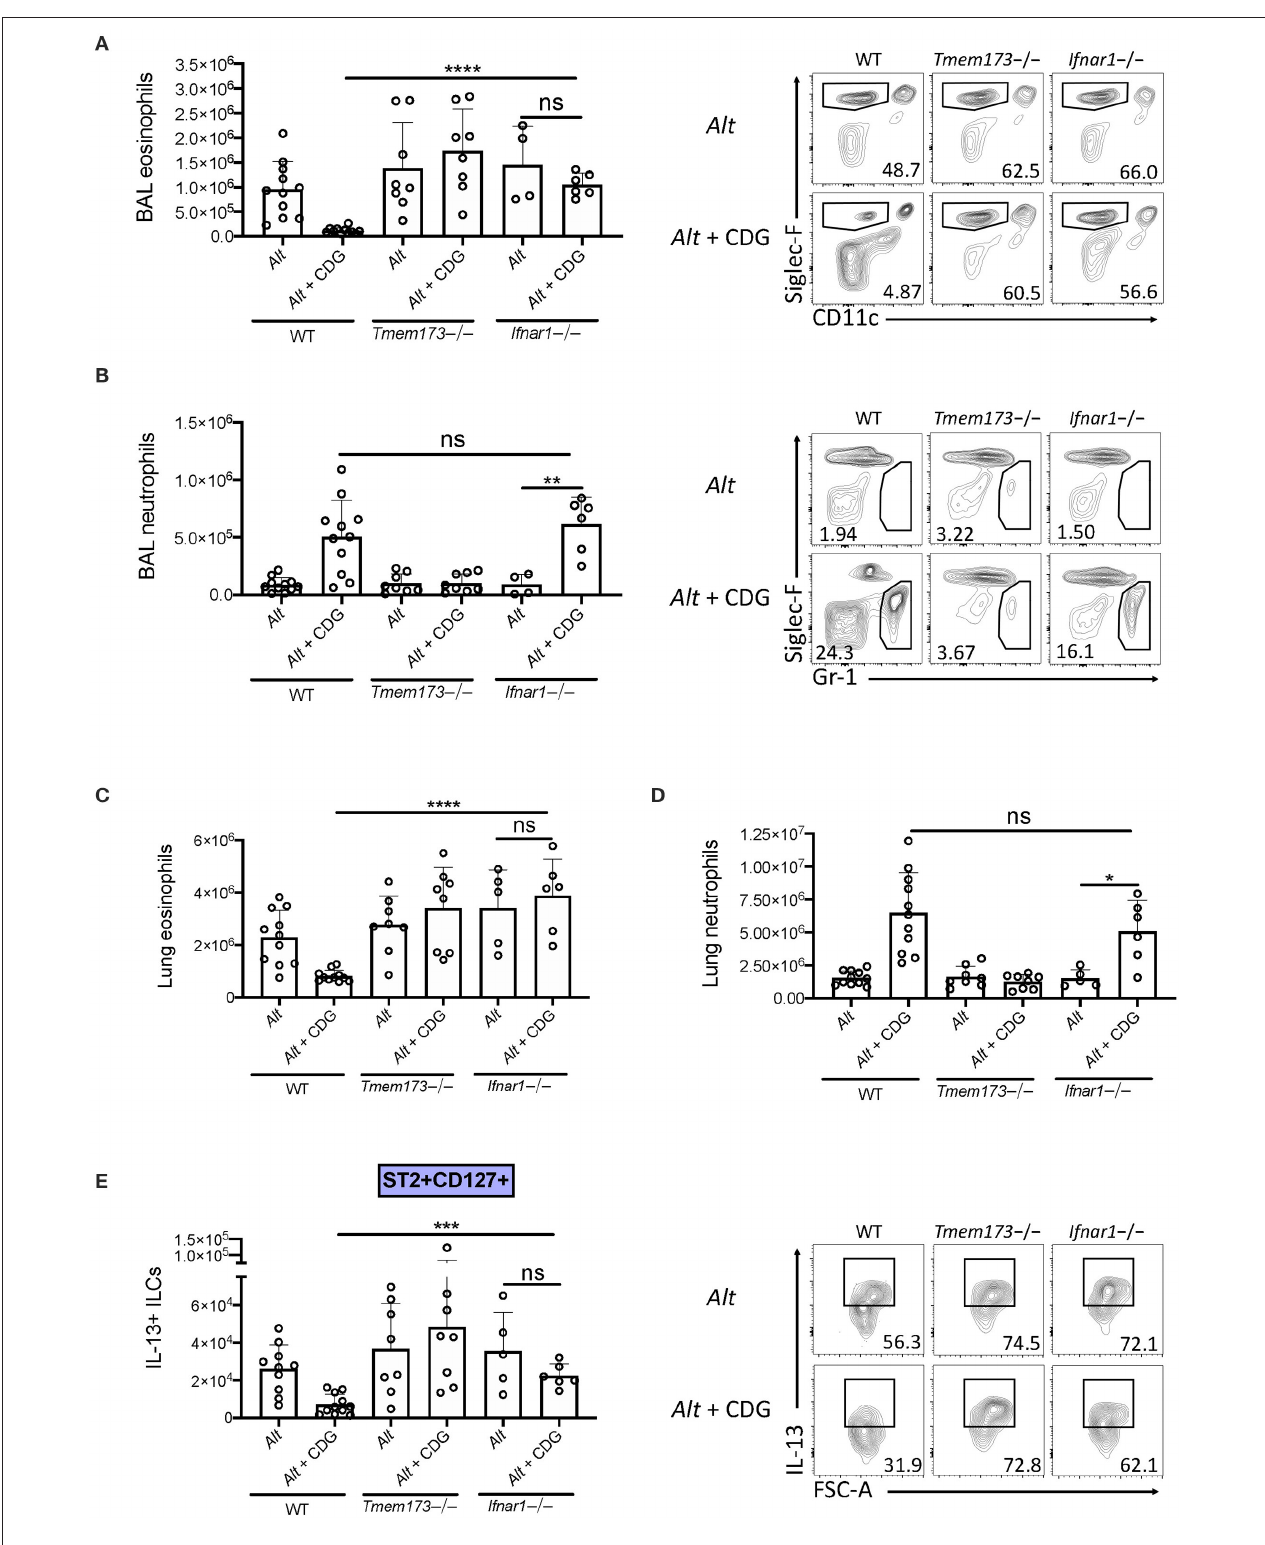
FIGURE 5 | Type 1 IFN signaling is required for CDG induced suppression of ILC2s and type 2 inflammation. Wild type, Tmem173 -/-, and Ifnar1 -/- mice were challenged using the same model as in Figure 1A . (A) Total number of BAL eosinophils (left) and representative plots (right). (B) Total number of BAL neutrophils (left) and representative flow plots (right). (C) Total number of lung eosinophils. (D) Total number of lung neutrophils. (E) Total number of IL-13 + ST2 + CD127 + ILC2s (left) and representative flow plots (right). Data shown are representative of 5 independent experiments with 1–3 mice per group. * P < 0.05, ** P < 0.01, *** P < 0.001, **** P < 0.0001, unpaired t